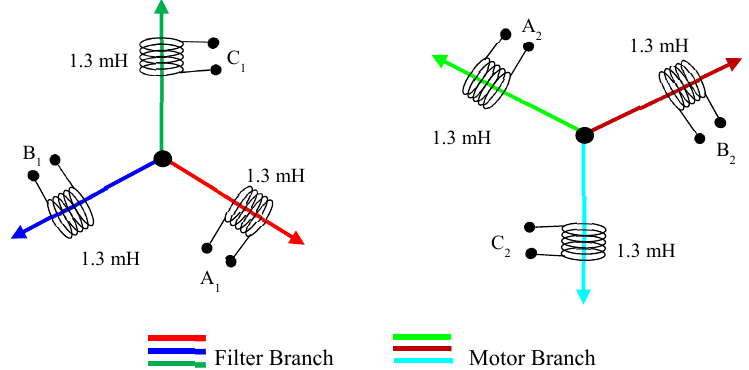
Figure 6. Traditional and integrated PMSM drive system ( a ) with conventional separate filter ( b ) with integrated filter.